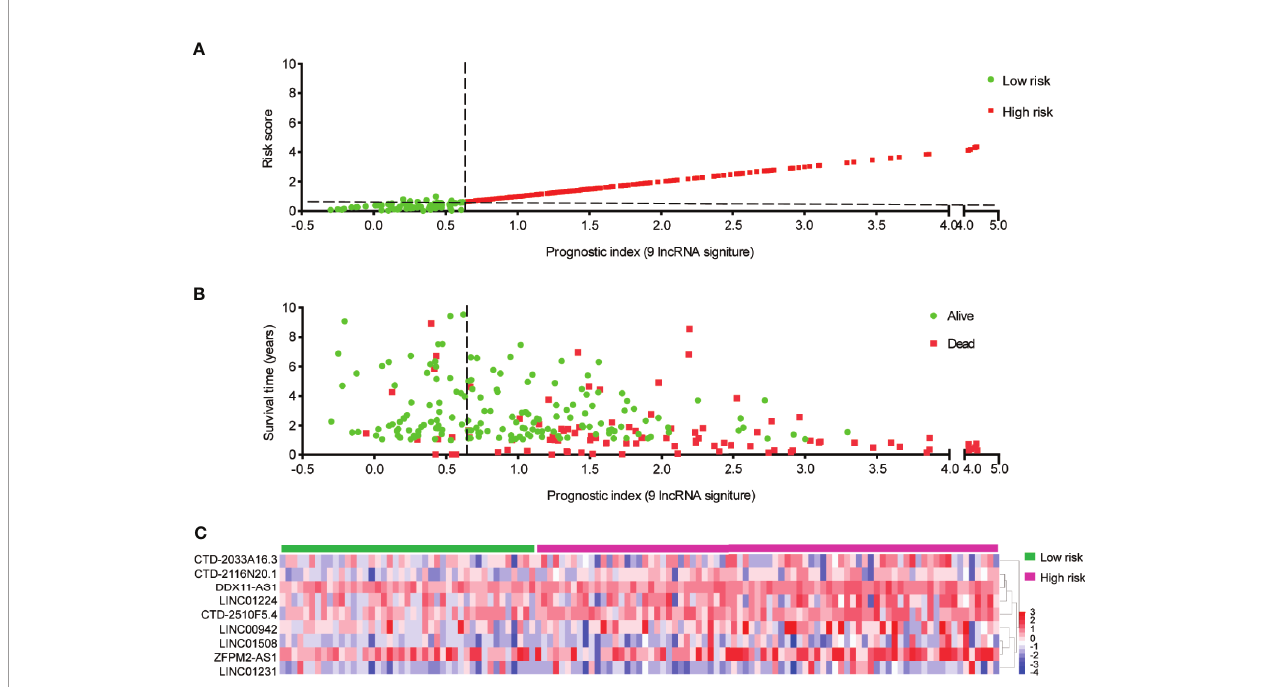
FIGURE 4 | Distribution of hepatocellular carcinoma (HCC) patients based on the risk score. (A) Risk curve and (B) scatter plot for the risk score and survival status of each HCC case. The red and green dots in (B) represent death and survival, respectively. (C) Heat map showing the expression pro fi les of ferroptosis-associated nine-lncRNAs in the high-risk group and the low-risk